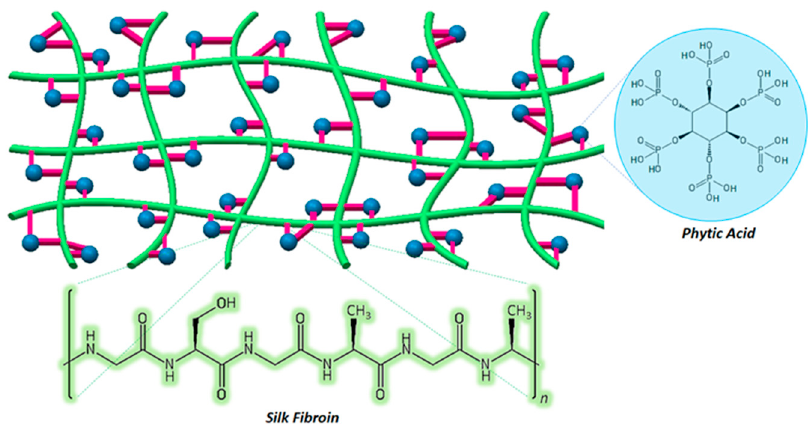
Figure 4. The proposed structural formation of 3-D porous network in SF:SS composites, in which phytic acids in SS powder cross-links the unstructured fibrous arrangement of SF and creates the pore structure in the composites.